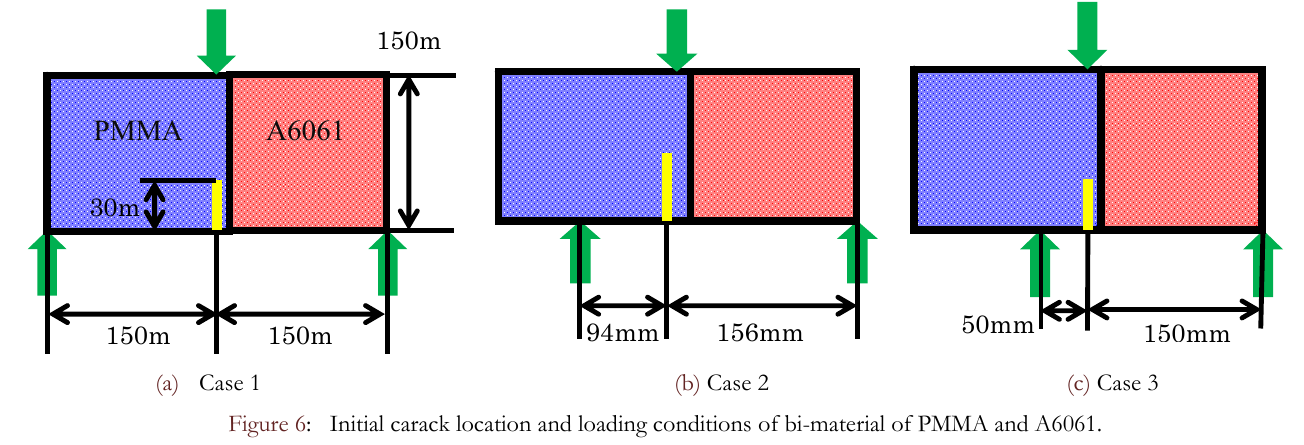
Figure 6: Initial carack location and loading conditions of bi-material of PMMA and A6061.